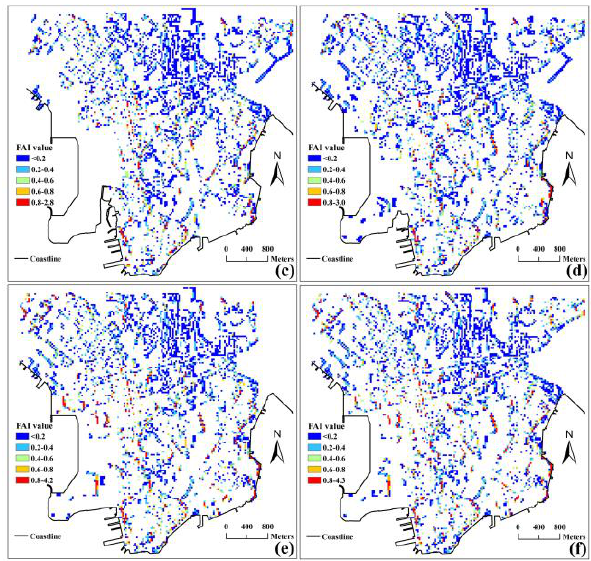
Figure 5. Spatial distribution of FAI at 30 spatial resolution. (a): 1985; (b): 1990; (c): 1995; (d): 2000; (e): 2005; (f): 2010